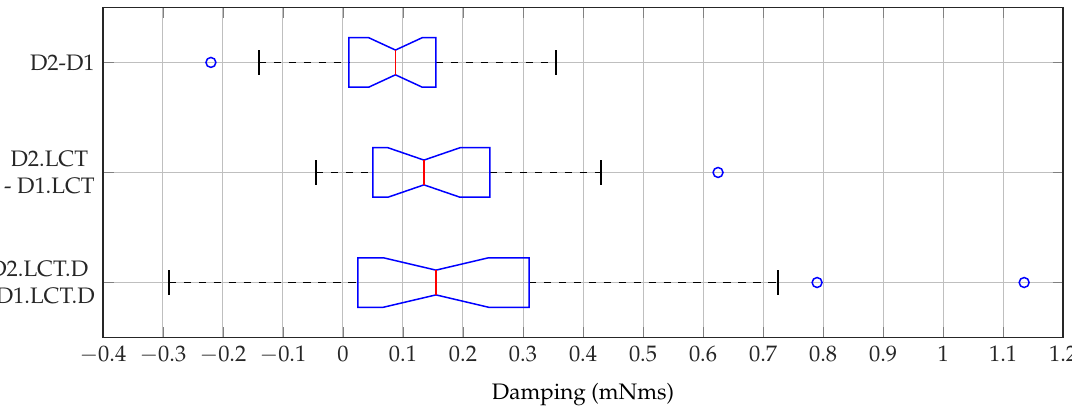
Figure 7. Effect of knob diameter on detection thresholds with respect to distraction and detent. Differences are significantly different from zero and are correlated to knob diameter.